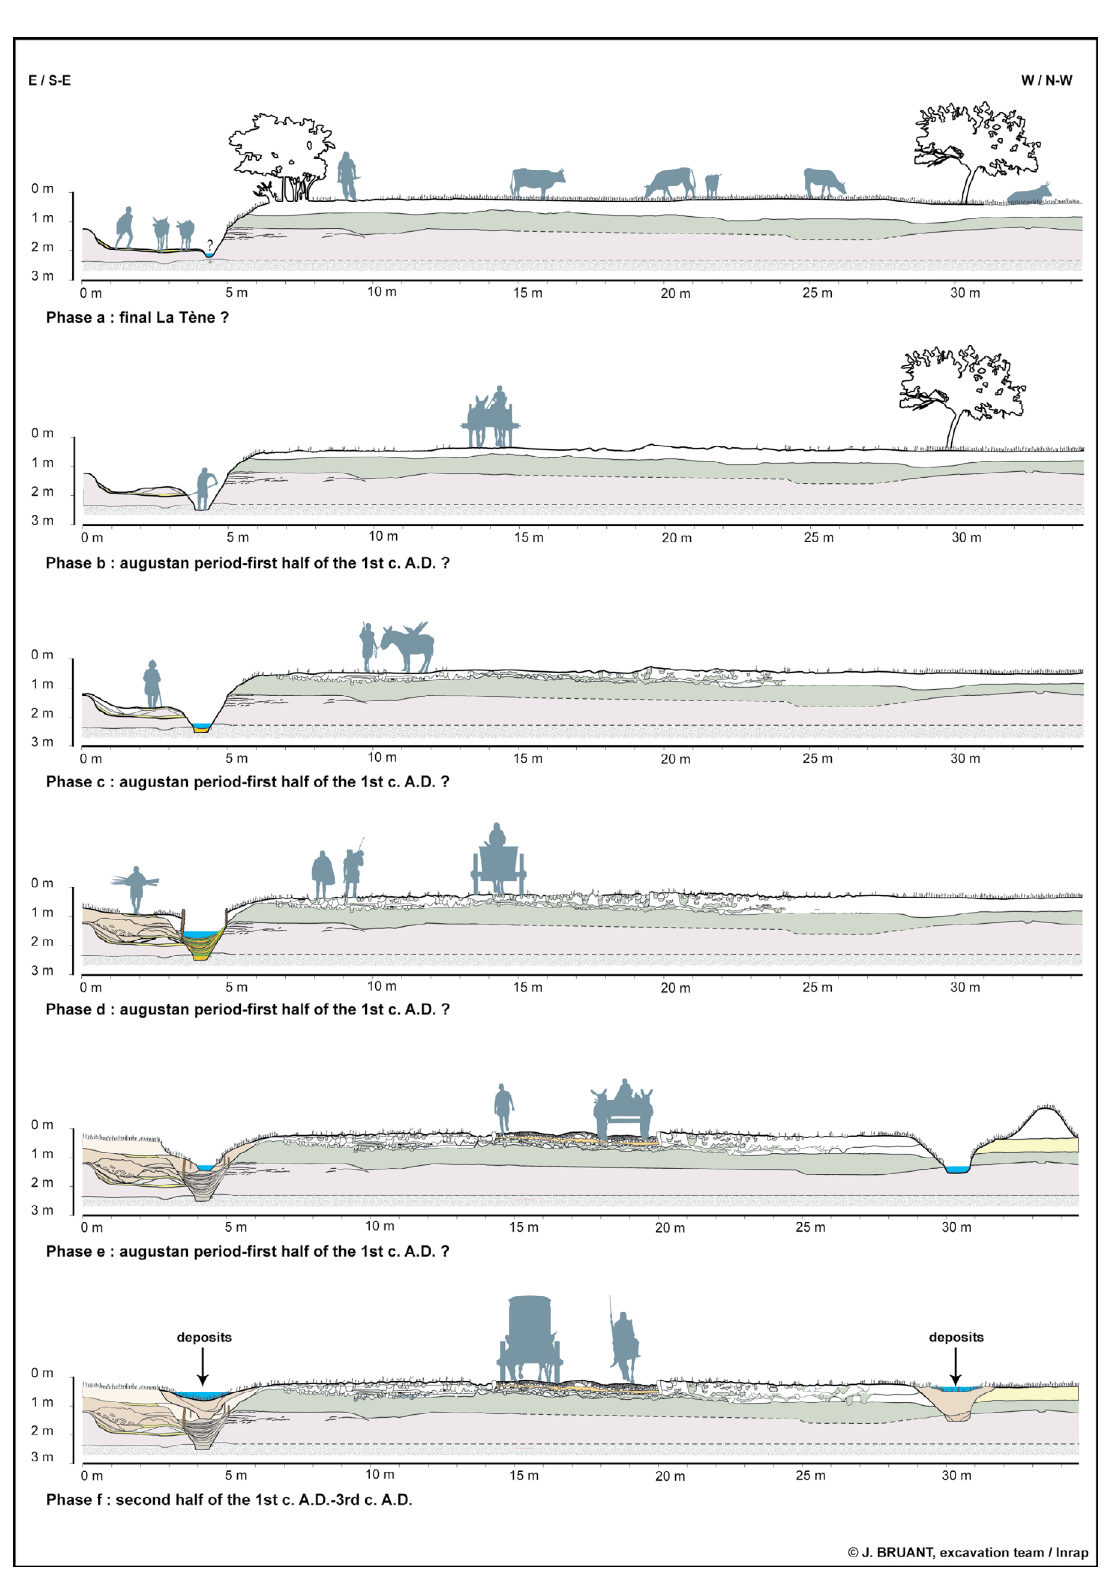
Figure 5. The restitution of the Cenabum-Lutecia road evolution (Late La Tène-gallo-roman period) based on the observations made during the excavation campaign lead by Inrap in Massy (Essonne)/Rue du Pérou. © J. Bruant, Équipe de